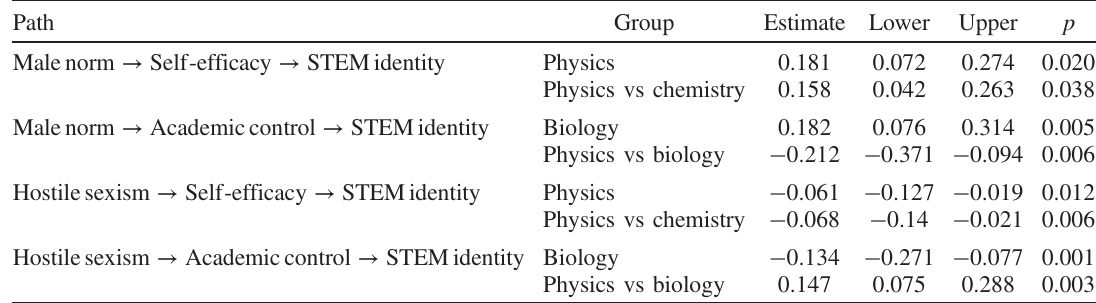
TABLE VI. Unstandardized indirect effects of the gender stereotypes on disciplinary identity for the three groups of students involved in the